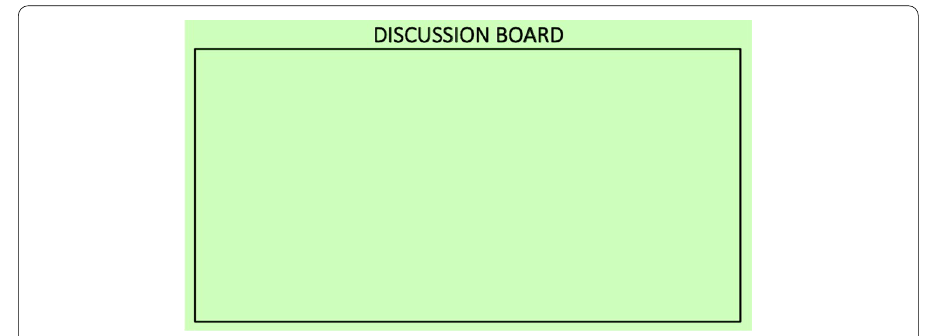
Fig. 10 Sample Discussion Board